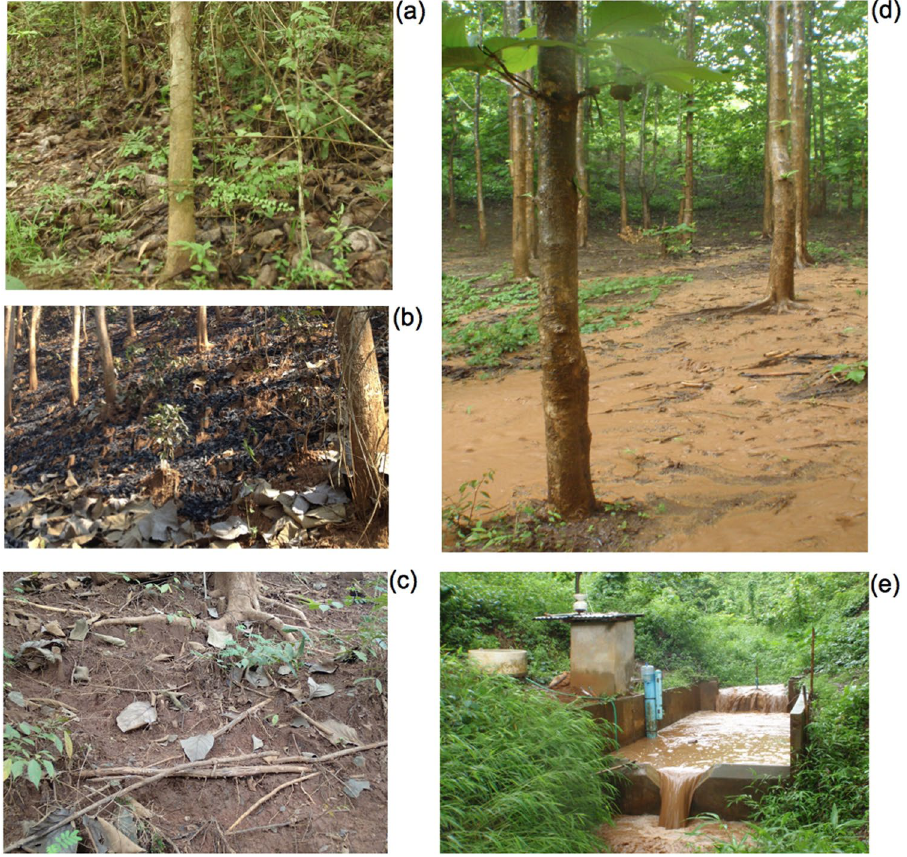
Figure 6. Pictures taken in the Houay Pano catchment: ( a ) teak understorey in natural conditions (vegetation and litter are present); ( b ) teak understorey after a fire (litter and vegetation virtually cleared); ( c ) degraded soil surface with erosion crust and exposed teak roots; ( d ) sheet overland flow under a teak plantation during a rainfall event; ( e ) the hydrological station (so-called S4 station) equipped with a sediment trap for the quantification of bed load (larger blue PVC tube), an automatic sampler for the estimation of suspended solid load, a water level recorder and V-nutch weir to monitor the stream discharge, and a probe for measuring the electrical conductivity of stream water (in the smaller blue PVC